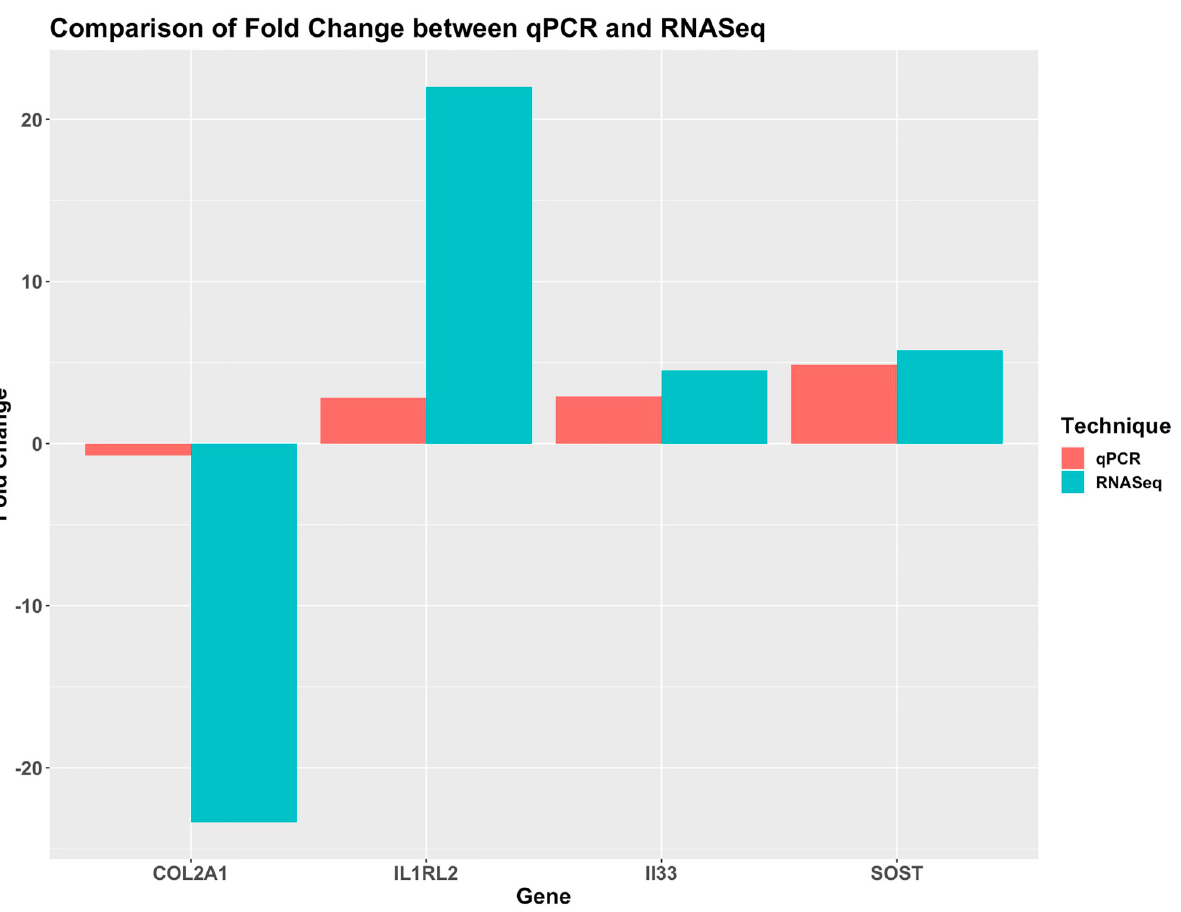
Fig 7. A bar chart comparing the fold change of qPCR results to the log-fold-change from RNA-sequencing. A similar trend is observed between the qPCR and RNA-sequencing results.